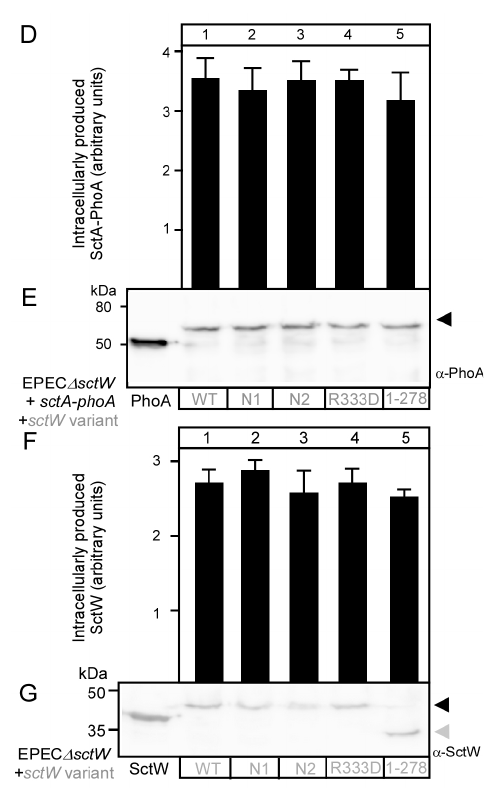
Figure 4. Functional characterization of sctW mutants. ( A ) Quantification of SctA-PhoA secreted extracellularly from EPEC ∆ sctW cells complemented with sctW or mutant variants (as indicated) carried on the pASK-IBA7 + vector. Bar graphs with SEM are shown; n = 3 biological repeats. Unpaired parametric t -test was performed, *: p < 0.01. ( B ) Quantification of chromosomal SctA secreted extracellularly from EPEC ∆ sctW cells complemented with sctW or mutant variants. Signal intensities were quantified using Image J software (Schneider et al., 2012) and are shown in bar graphs with SEM; n = 3 biological repeats. *: p < 0.01. ( C ) Image of a representative western blot analyzing extracellularly secreted SctA in EPEC ∆ sctW cells complemented with sctW or mutant variants (as indicated). Polypeptides were analyzed as in Figure 1D, and immuno-stained with α -SctA . Left: 50 ng of SctA, purified as previously described [16]. The arrow indicates SctA. A representative image is shown; n = 3 biological repeats. ( D ) Quantification of inracellularly produced SctA-PhoA (as in B ). Bar graphs with SEM are shown. n = 3 biological repeats. ( E ) Intracellular production of SctA-PhoA in EPEC ∆ sctW cells carrying sctW or derivatives (as indicated). Polypeptides were analyzed as in Figure 1D. Left: 100 ng of PhoA-His purified as previously described [15]. Black arrows: SctA-PhoA. A representative image is shown; n = 3 biological repeats. ( F ) Quantification of SctW signal intensities (as in B ). Bar graphs with SEM are shown; n = 3 biological repeats. ( G ) Intracellular production of SctW or of the indicated mutant derivatives. Polypeptides are analyzed as in Figure 1D, and immuno-stained with α -SctW. Left: 100 ng of SctW purified as described previously [48]. Arrows: SctW and SctW (R333D) (black) and truncated SctW (gray). A representative image is shown; n = 3 biological repeats.